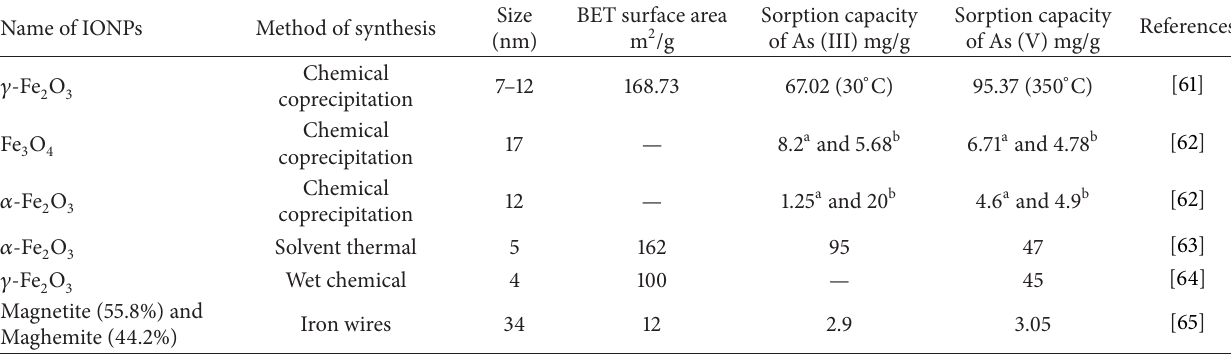
Table 2: Application of iron oxides nanaparticles for removal of arsenic according to the Langmuir isotherm.